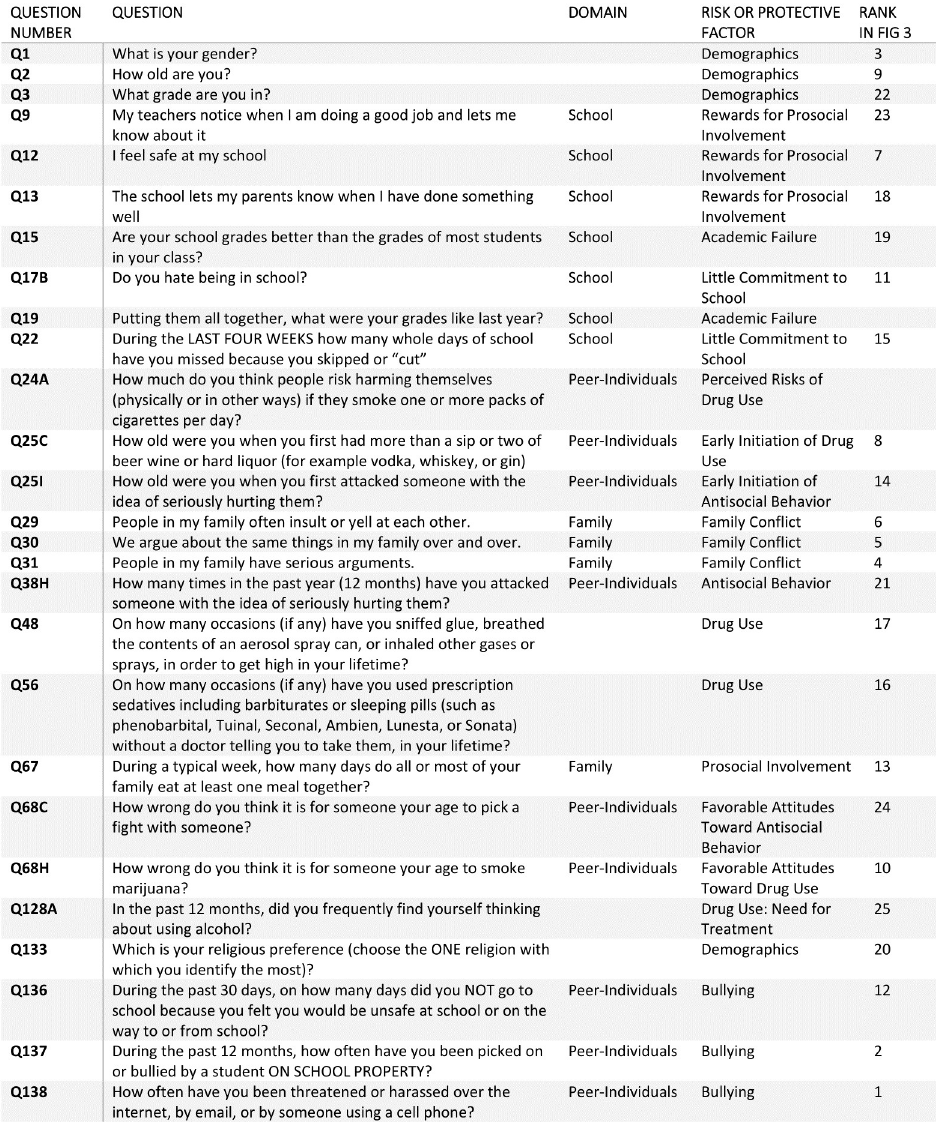
Fig 4. Most predictive questions for adolescent suicidal thoughts and behavior (non-ranked). A table of the most predictive questions, along with which domain and risk and predictive factor they involve, if applicable.